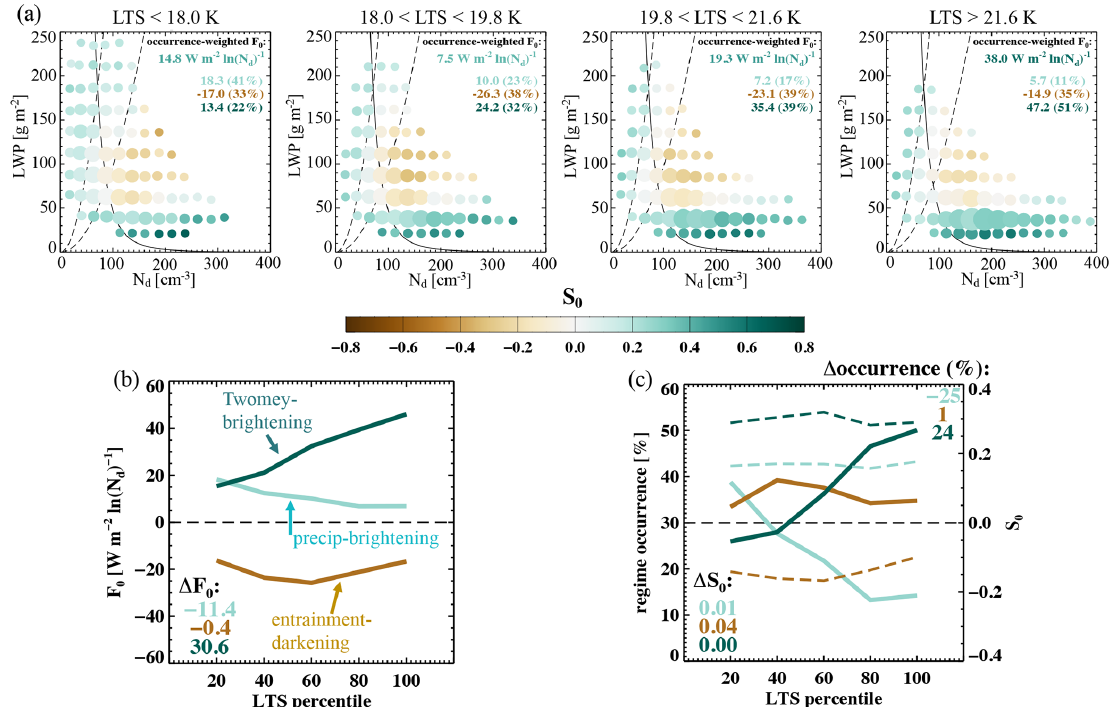
Figure 7. As in Fig. 6 but for lower-tropospheric stability (LTS).